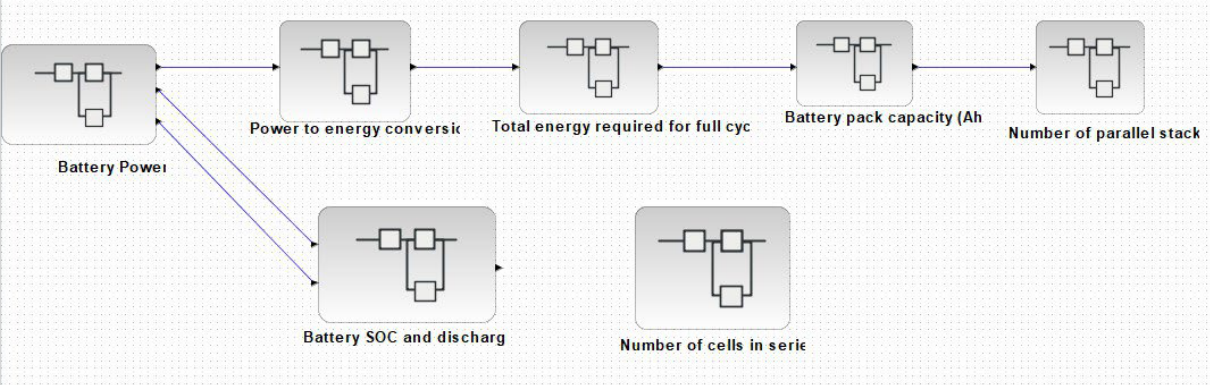
Figure 7. Battery sizing math model.